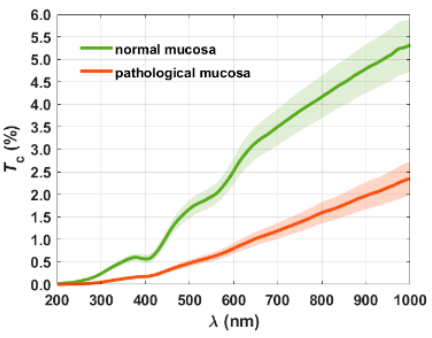
Figure 6. Mean T c spectra of the normal and pathological mucosa.